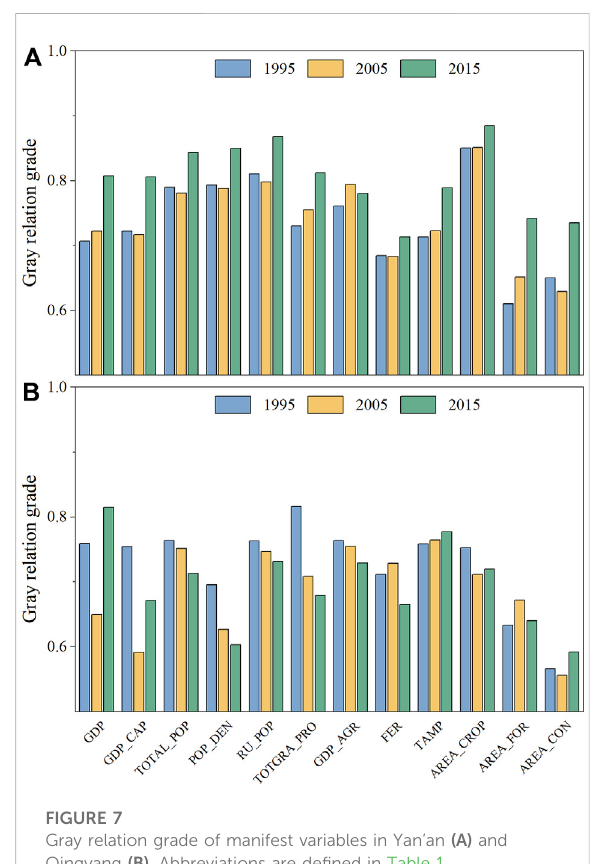
FIGURE 7 Gray relation grade of manifest variables in Yan ’ an (A) and Qingyang (B) . Abbreviations are de fi ned in Table